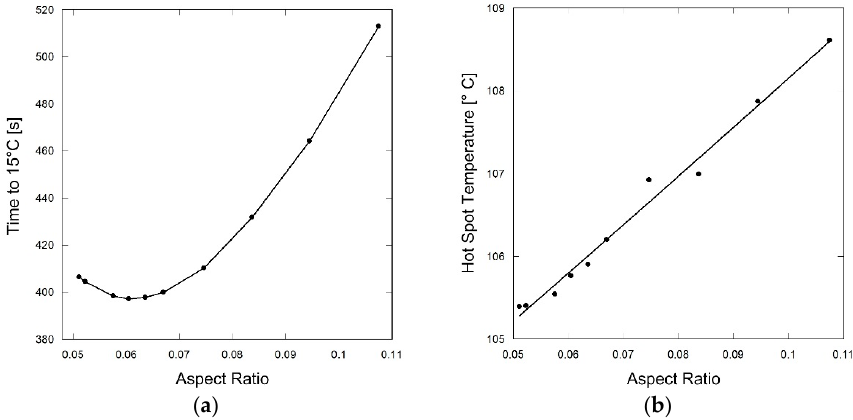
Figure 5. The results of simulations for the eight ‐ fin reactor. ( a ) Time required to cool to 15 °C; ( b ) Hot spot temperature.